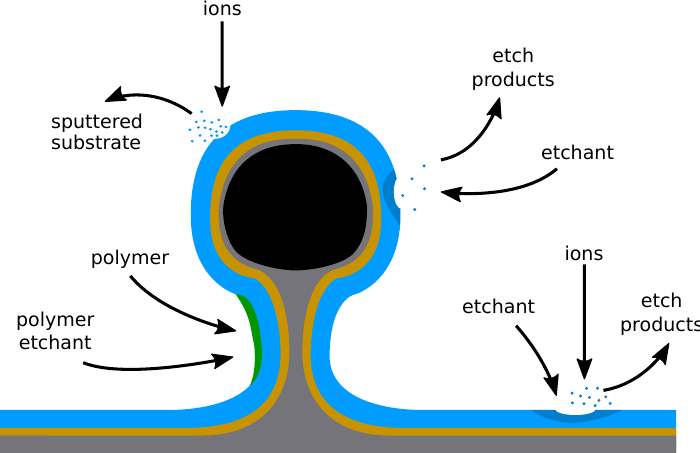
Figure 11. Four physical processes, which are considered when describing a modern plasma etch process used for gate stack pattering. Passivating species form polymer layers on sidewalls, as there are fewer energetic ion impacts to remove them from these surfaces. Ion sputtering removes material from the substrate by physical sputtering without the involvement of a chemical etchant. Purely chemical etching removes material by forming volatile etch products, which then desorp from the surface. Ion-enhanced etching speeds up this process by breaking existing bonds, enhancing the formation of volatile etch